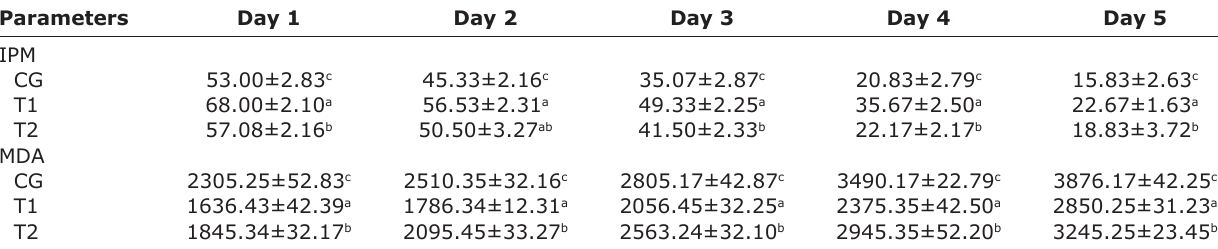
Table-4: Effect of L-arginine addition in skim milk extender chilled for a 5-day evaluation on the intactness of the plasma membrane (IPM) and the MDA level (nmol/ml) of goat spermatozoa. Parameters